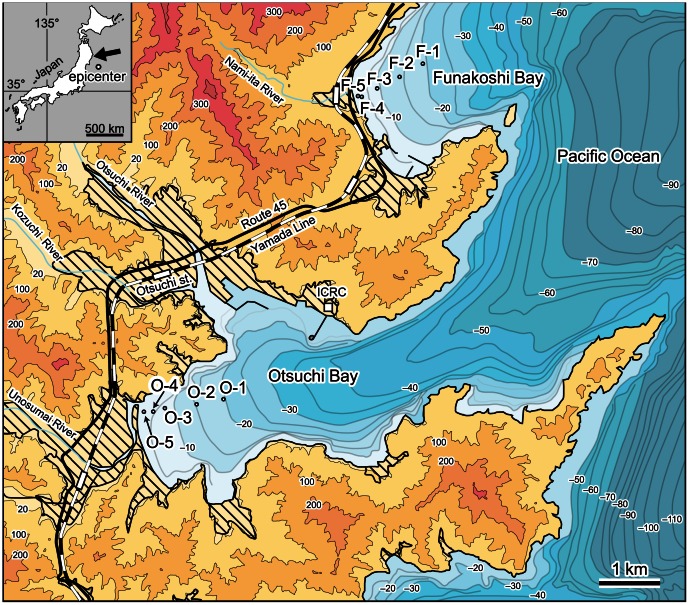
Map of the study area and sampling stations.The striped area represents tsunami inundation. Open circles represent sampling stations (O-1 to O-5 in Otsuchi Bay; F-1 to F-5 in Funakoshi Bay). ICRC: International Coastal Research Center, Atmosphere and Ocean Research Institute, the University of Tokyo. The map inset shows the epicenter of the 2011 M9.0 Tohoku-Oki earthquake and the study site (black arrow).